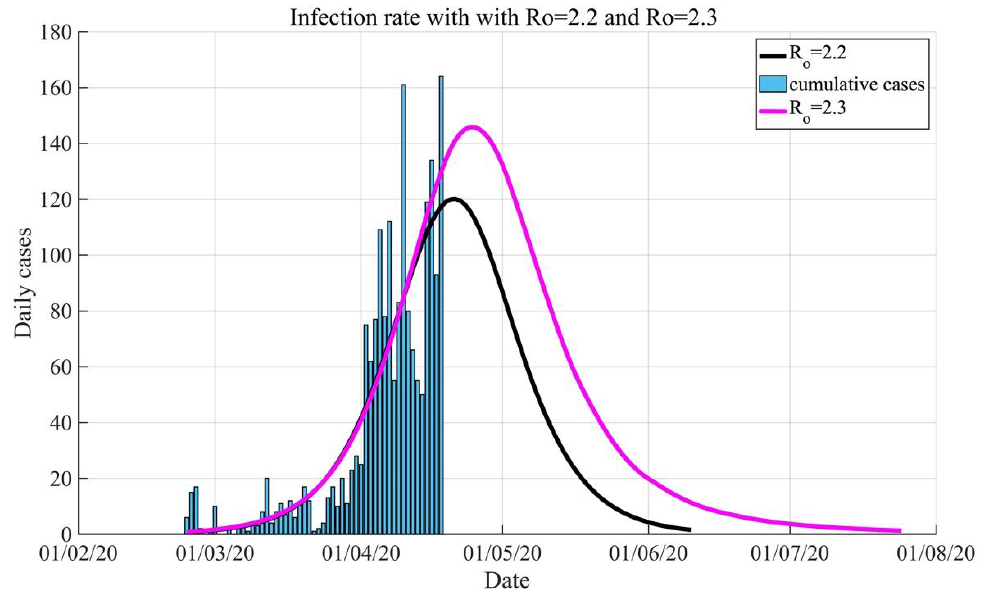
Figure 6. Predicted infection rates with various reproduction number of R o = 2.2 and R o = 2.3 Table 6. SIR simulation parameters with various reproduction numbers.